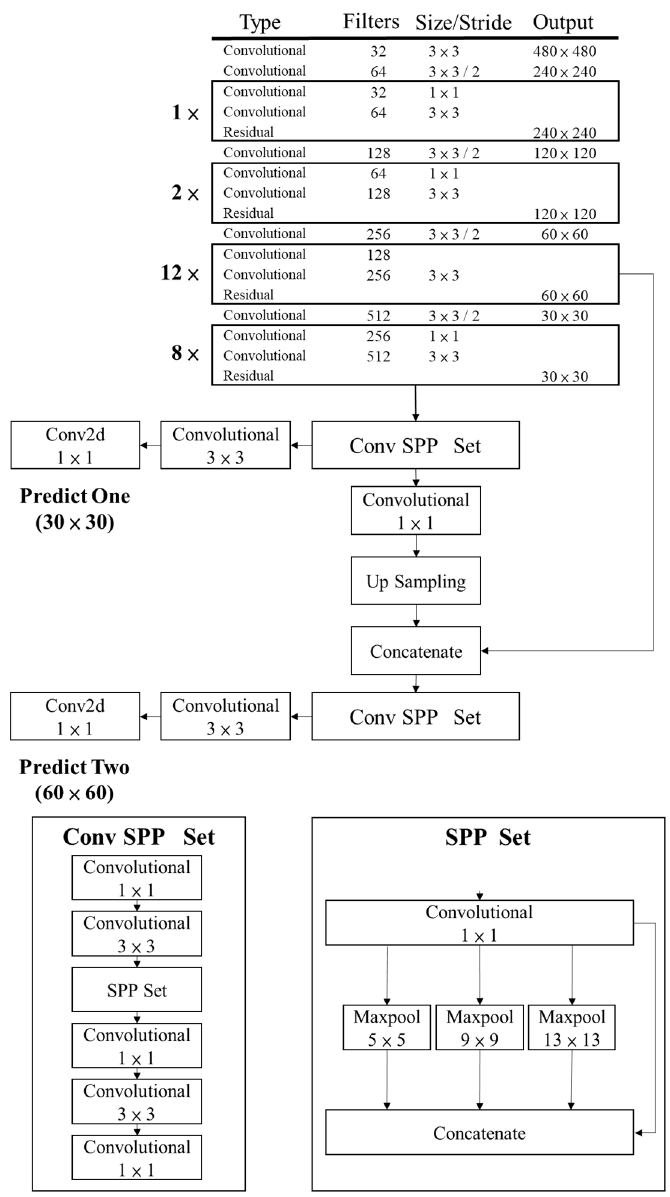
Figure 6. The YOLOv3 SPP two-scale output network architecture.